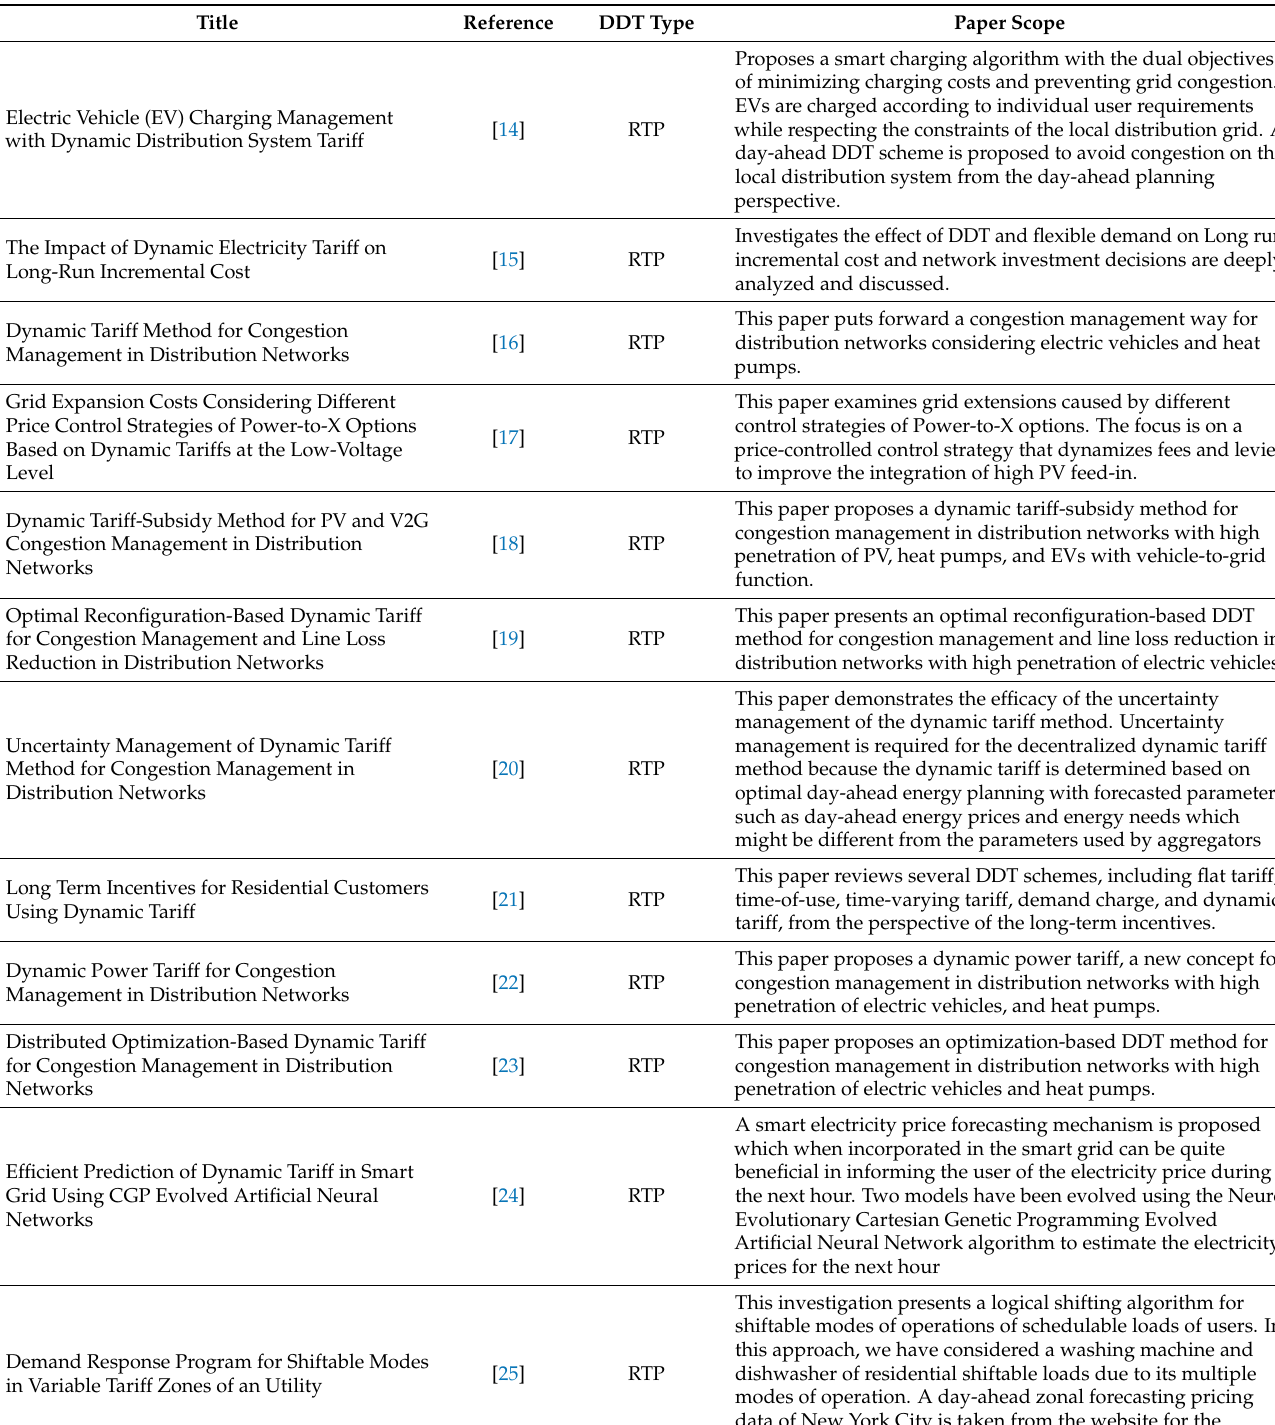
Table 1. Literature on dynamic distribution